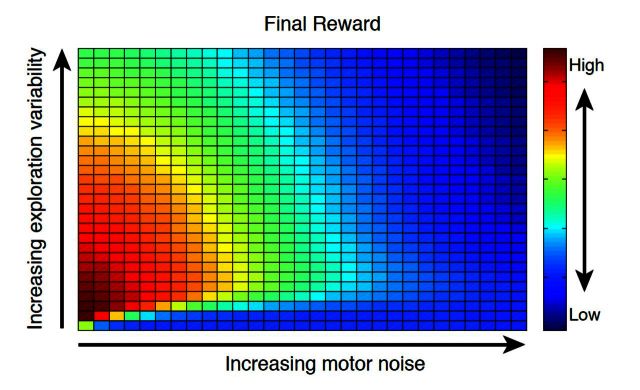

See Miall and Galea (doi:
10.1093/awv343
) for a scientific commentary on this article.

Cerebellar lesions impair both coordination and motor learning. Therrien
et al.
show that affected individuals can learn using a reinforcement mechanism despite a deficit in error-based motor learning. They also identify a critical feature of cerebellar patients’ movements (motor noise), which determines the effectiveness of learning under reinforcement.